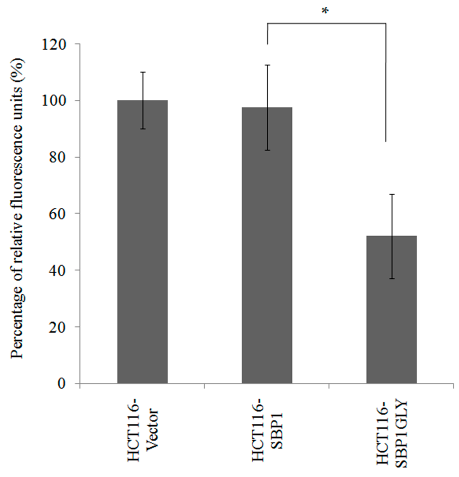
Figure 5. SBP1 GLY induced mitochondrial damage in HCT116 cells. Mitochondrial damage in HCT116